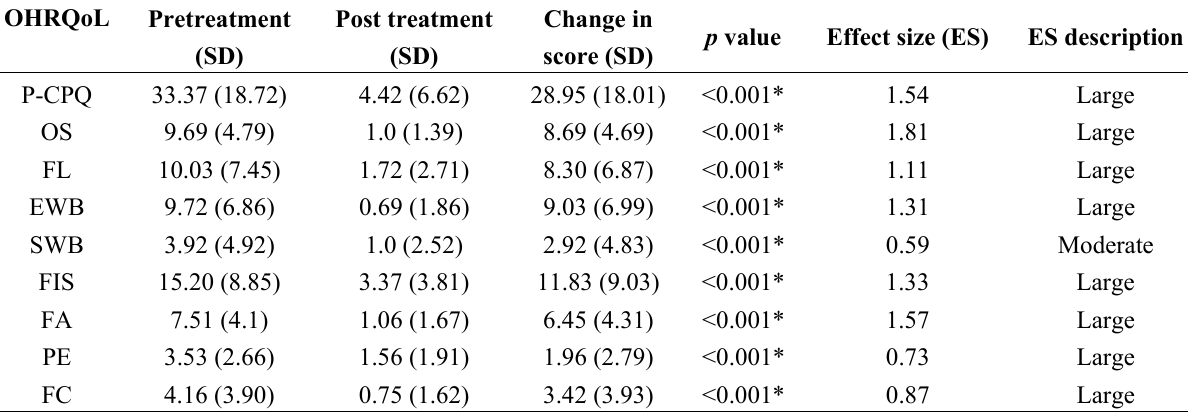
Table 4. Mean overall and domain scores in the Parental-Caregivers Perceptions Questionnaire (P-CPQ) and Family Impact Scale (FIS) at baseline and follow-up, change score, and effect sizes.